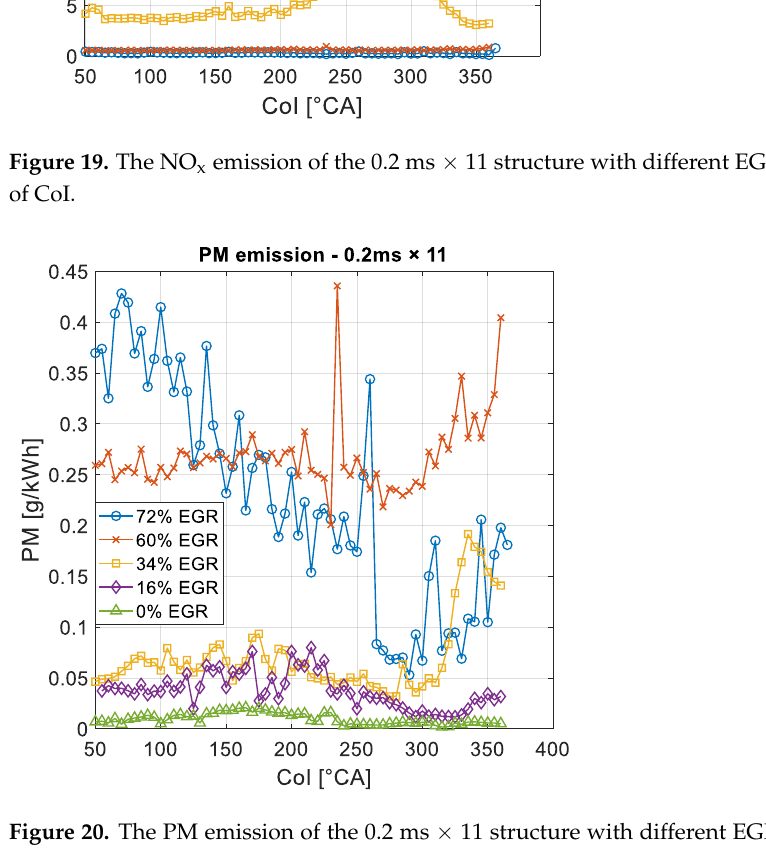
Figure 20. The PM emission of the 0.2 ms × 11 structure with different EGR rates in the function of CoI.